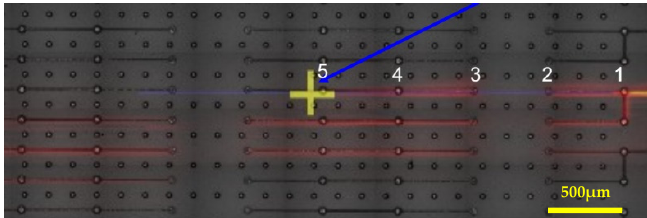
Figure 10. Optical images overlay with Current images